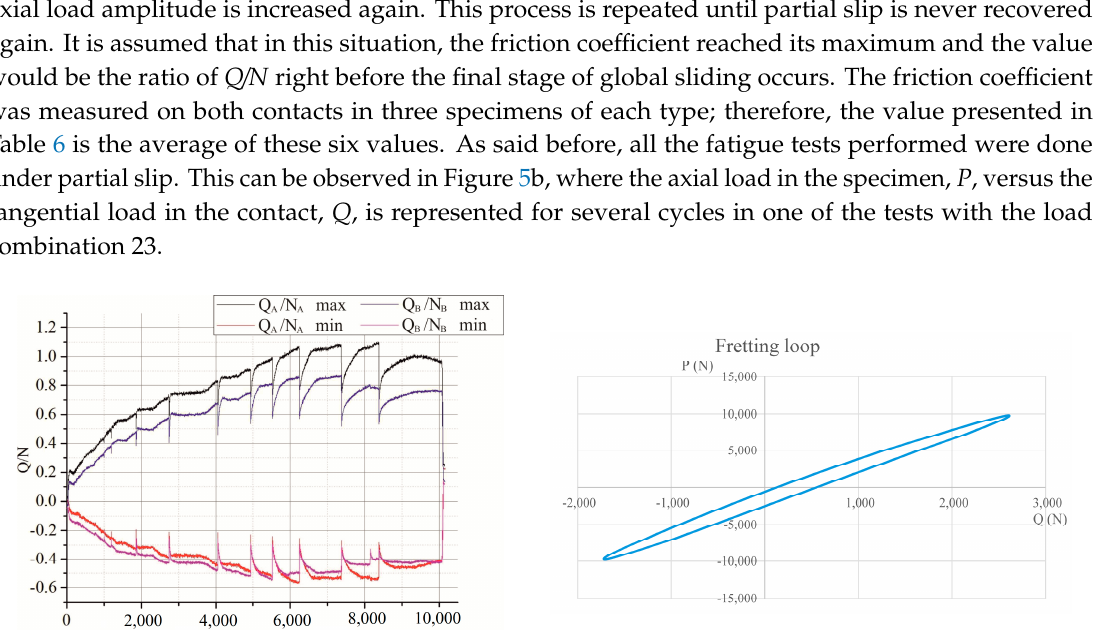
Figure 6. Hardness in a specimen treated with shot peening.